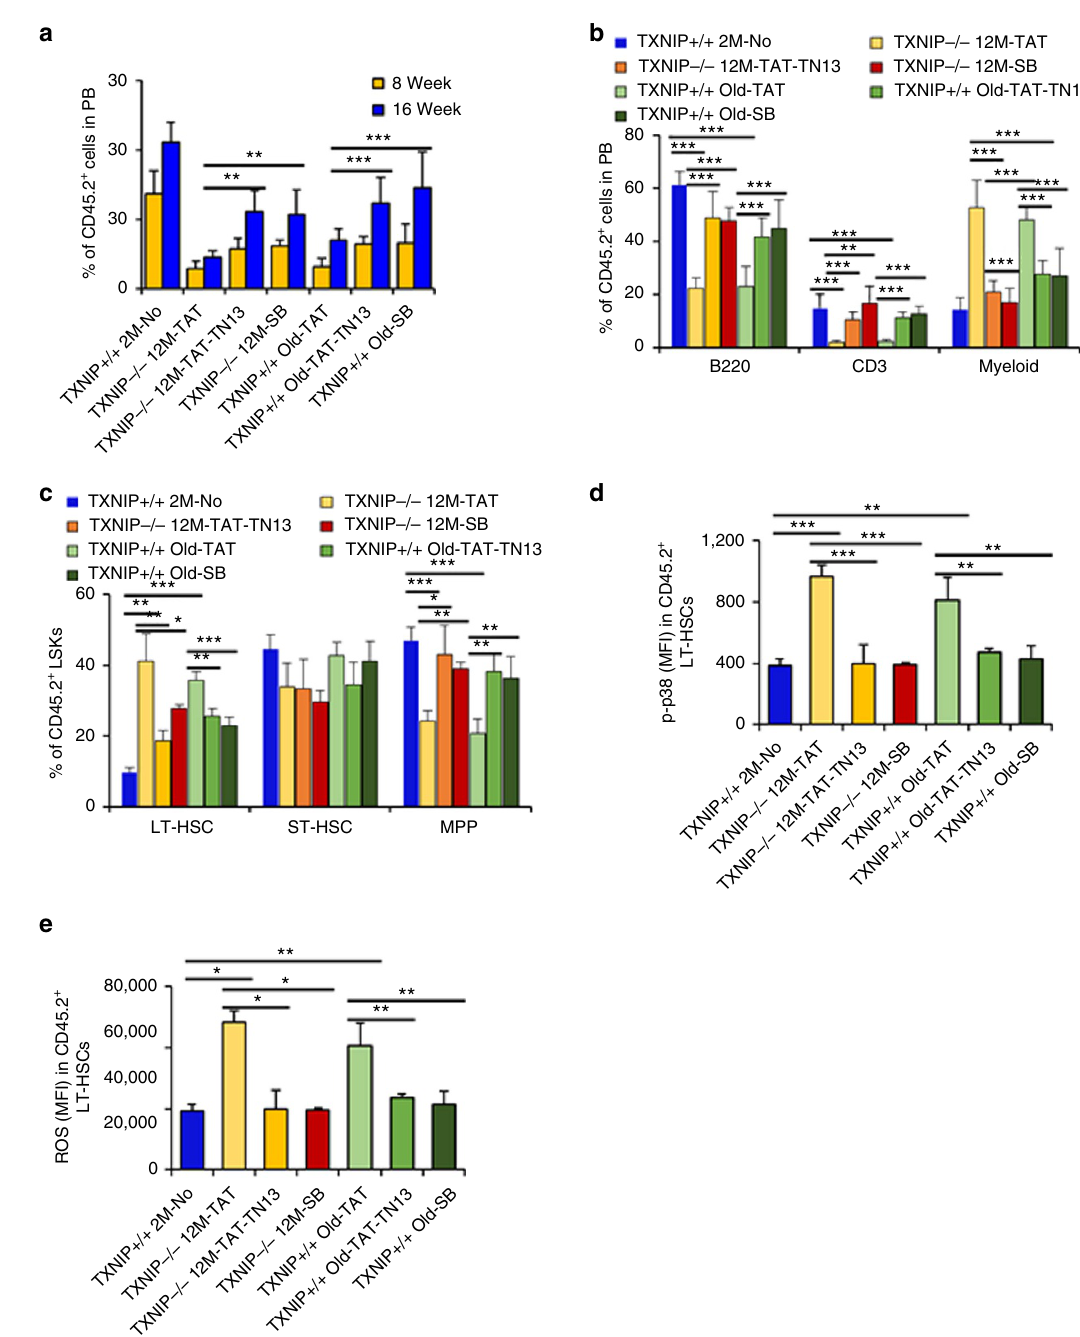
Figure 6 | Rejuvenation of aged HSCs by TAT-TN13 in vivo. ( a , b ) Distribution of donor-derived WBCs in PB ( a ) and percentage of B220 þ , CD3 þ and myeloid cells among donor-derived WBCs in PB ( b ). Five hundred LT-HSCs were i.v. injected with competitor BM cells ( CD45.1 þ , 1.5 (cid:3) 10 6 ) into lethally irradiated (9Gy) CD45.1 þ congenic recipients ( n ¼ 8–13). ( c – e ) LT-HSCs, ST-HSCs and MPPs among donor-derived LSKs in BM ( c ) ( n ¼ 5–6), levels of phospho-p38 ( d ) and levels of ROS in donor-derived LT-HSCs ( e ) ( n ¼ 5). Data are mean ± s.d. Statistical significance was determined using a two-tailed Student’s t -tests. * P o 0.05, ** P o 0.01, *** P o 0.001.